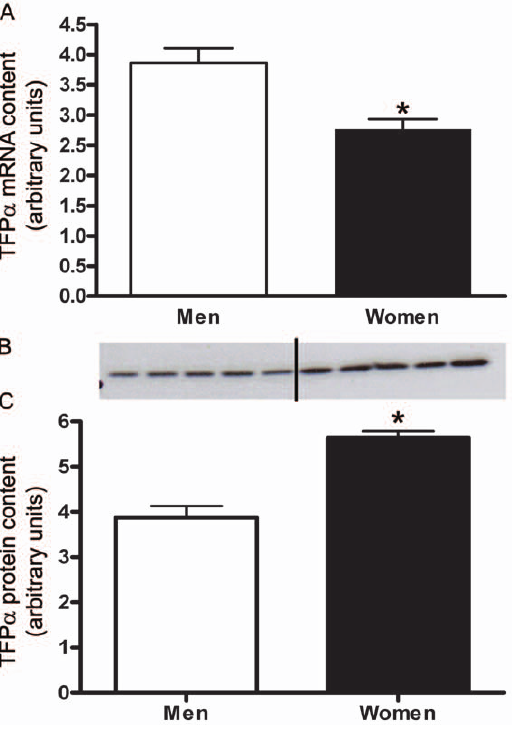
Figure 3. TFP a protein content is higher in women than men. Differences in TFP a mRNA content between men and women shown by Real time RT-PCR, adjusted to b 2-M mRNA (A). Protein content of TFP a in skeletal muscle of men and women, adjusted to CS (B,C). Representative western blot (B) Lanes 1–5 are men, lanes 6–10 are women. N=12 men and 11 women. *P # 0.05.